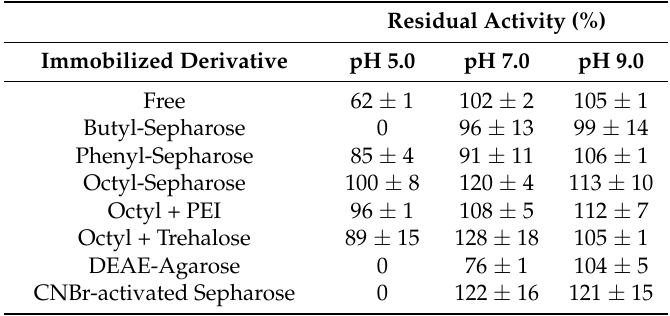
Table 3. pH stability of free and immobilized lipase at 25 ◦ C. Values are the average of three independent replicates; error bars represent average ± one standard